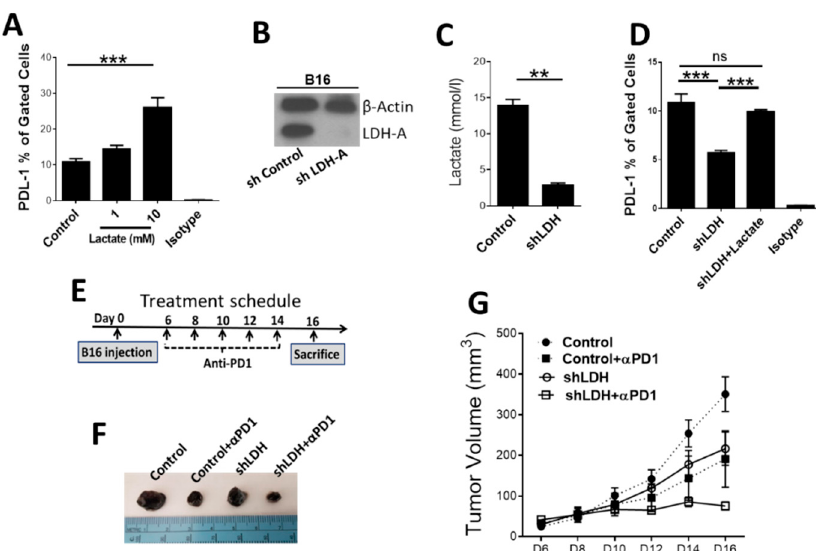
Figure 1. Lactate induces expression of programmed cell death protein-1 ligand (PD-L1) on B16 melanoma cells and deletion of lactate dehydrogenase-A (LDH-A) in B16 cells or anti-PD-1 therapy prevents tumor growth. ( A ) B16-F10 cells were treated with lactate (1 mM and 10 mM) for 24 h, and the level of PD-L1 was measured by flow cytometry. The number of PD-L1 + cells is shown as the percentage of gated cells. *** p < 0.001. ( B ) LDH-A was knocked down in B16-F10 melanoma cells using small hairpin RNA (shRNA) against LDH-A. Scramble shRNA was used as control. Western blotting with an antibody against LDH-A is shown on B16-green fluorescent protein (GFP) versus shLDH melanoma cells. ( C ) Capacity of lactate production was examined on B16-shLDH and control melanoma cells. ** p < 0.01. ( D ) B16-GFP and B16-shLDH melanoma cells were cultured in vitro and PD-L1 expression in the cells was measured by flow cytometry. *** p < 0.001, n = 3 independent experiments in triplicate. ( E ) Anti-PD-1 treatment schedule of mice tumor model. ( F – G ) Anti-PD-1 administration provided the same tumor growth inhibition as B16-shLDH tumor growth and anti-PD-1 injection induced additional tumor growth inhibition ( p < 0.05). ( F ) demonstrates representative tumor size at day 16 after induction of tumor. ns: not significant.